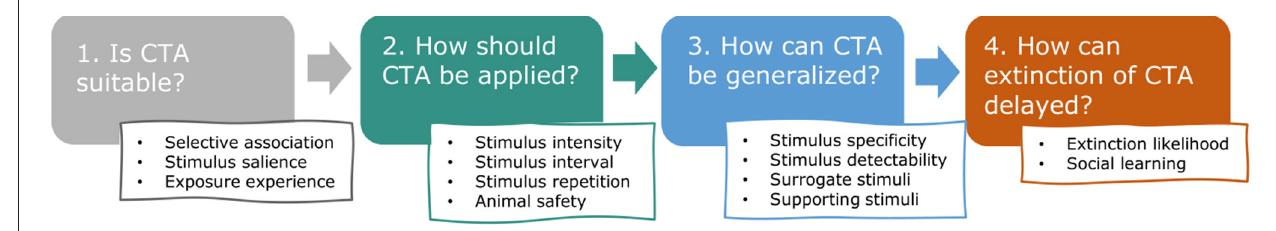
FIGURE 2 | Review outline. This review addresses, in chronological order, the key questions that arise when considering and applying conditioned taste aversion (CTA) to human-wildlife conflict (HWC) situations and highlights which aspects of learning theory and animal safety are especially